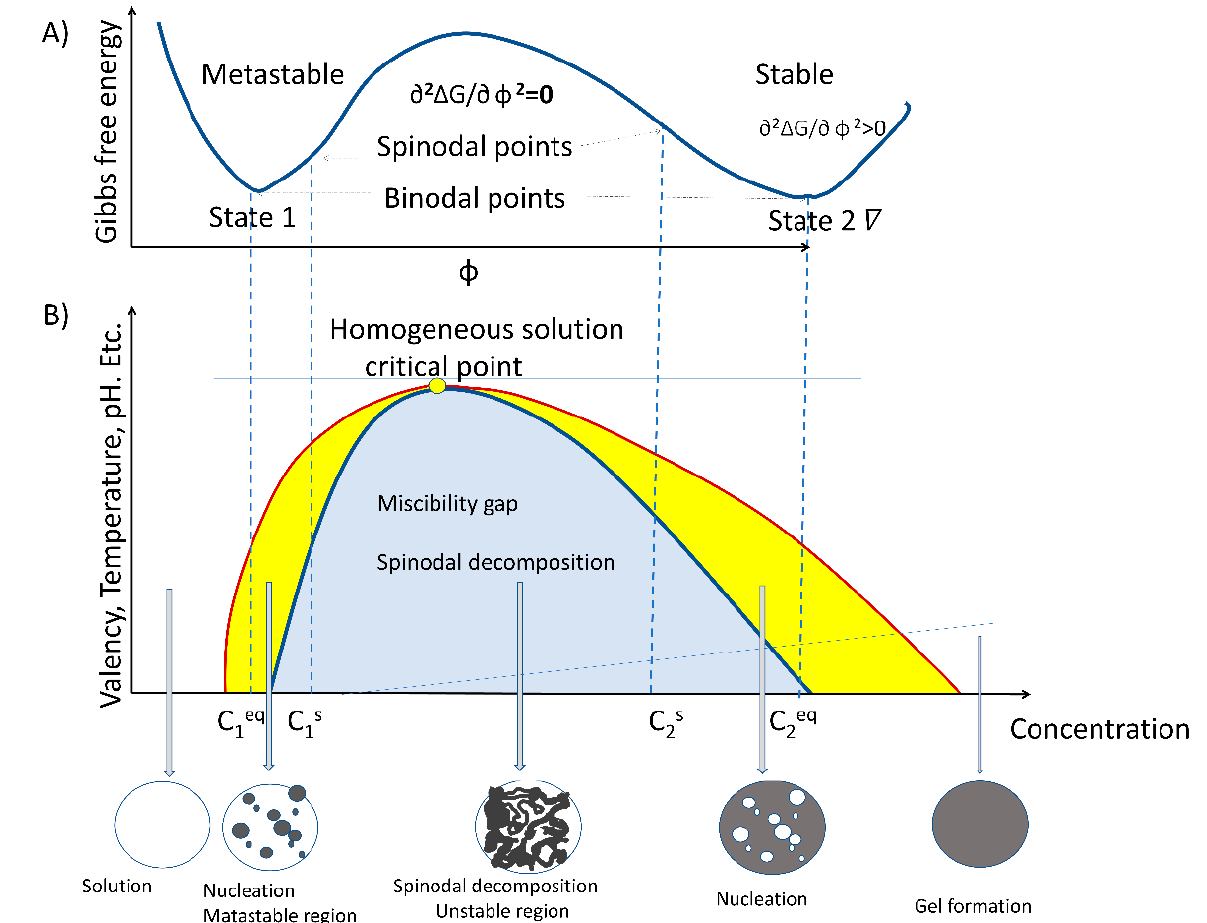
Figure 1. Schematic Gibbs free energy graph and the corresponding phase diagram. ( A ) Gibbs free energy graph shows the binodal and spinodal point where ∂ 2 ∆ G/ ∂ ϕ 2 can be greater than zero or equal to zero, respectively; this illustrates the metastable regions before the spinodal points where instability takes place, followed by stable gel or precipitate formation. ( B ) The coexistence line (RED) separates the one-phase and two-phase regimes and is a function of environmental conditions, such as temperature and pH. The system does not undergo phase separation beyond the critical point marked as a blue dot. At low concentrations, the system is in the one-phase solution. Passing into the yellow zone, we have the binodal section where nucleation can take place; this is higher still in concentration between the spinodal points, where ∂ 2 ∆ G/ ∂ ϕ 2 = 0 indicates the area region of instability in which the system must undergo demixing via spinodal decompo- sition.